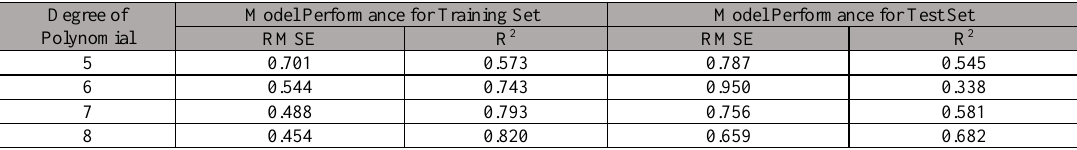
Table 2. Model performance comparison for the polynomials of degree 5 th to 8